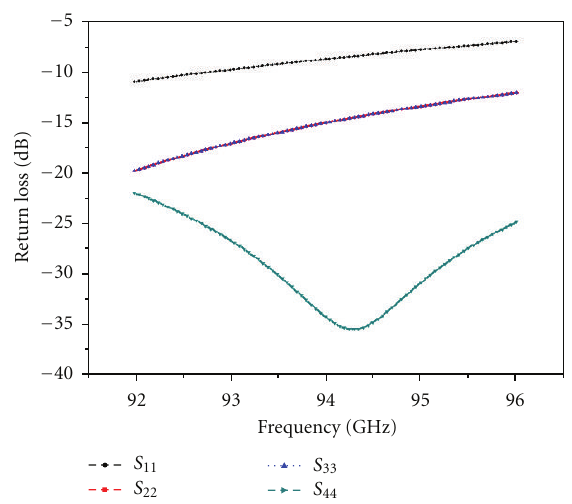
Figure 4: Half compensated E-FMT S -parameters of all